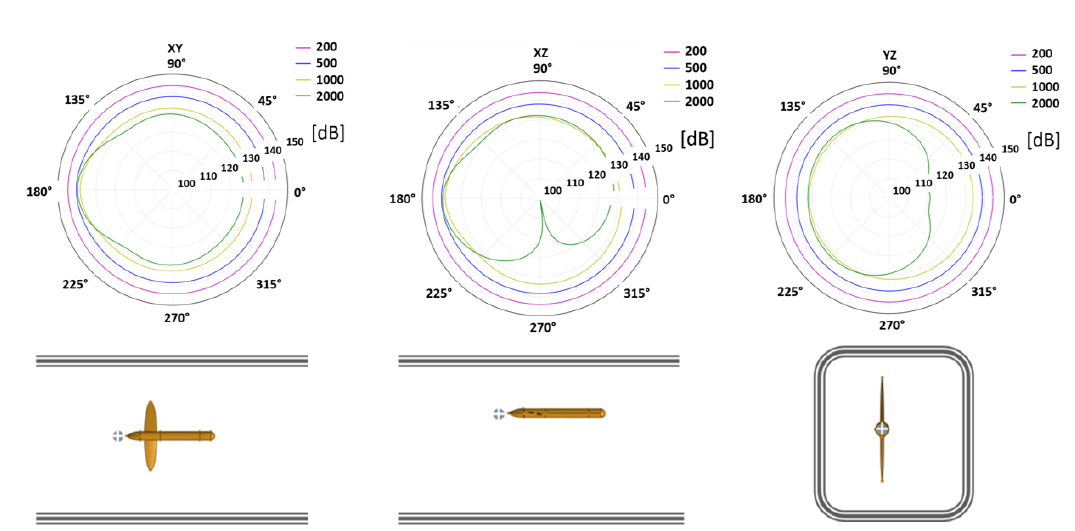
Figure 13. Directivity plots at 200 Hz, 500 Hz, 1000 Hz, and 2000 Hz. Monopole marked with + sign.